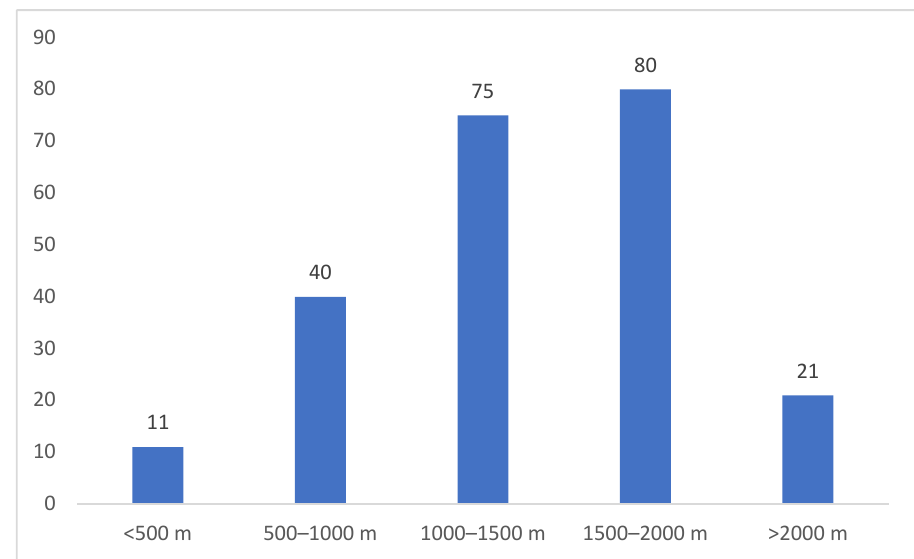
Figure 5. Distribution of distance from wind turbines to residences.